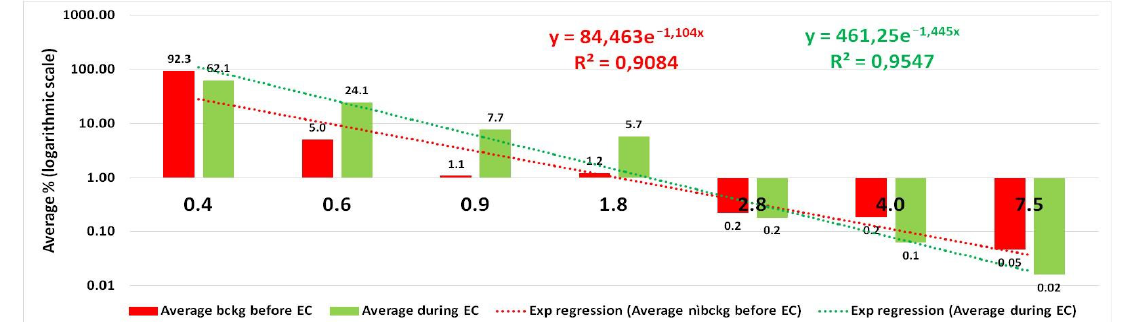
Figure 7. ECSHA profile comparison between background and during use of “JUUL” e-cigs.